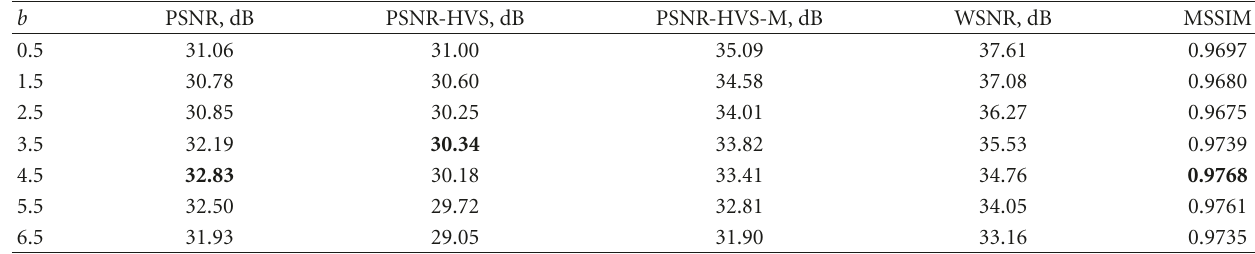
Table 4: Results for the image Barbara for the coder AGU, σ 2 = 50.